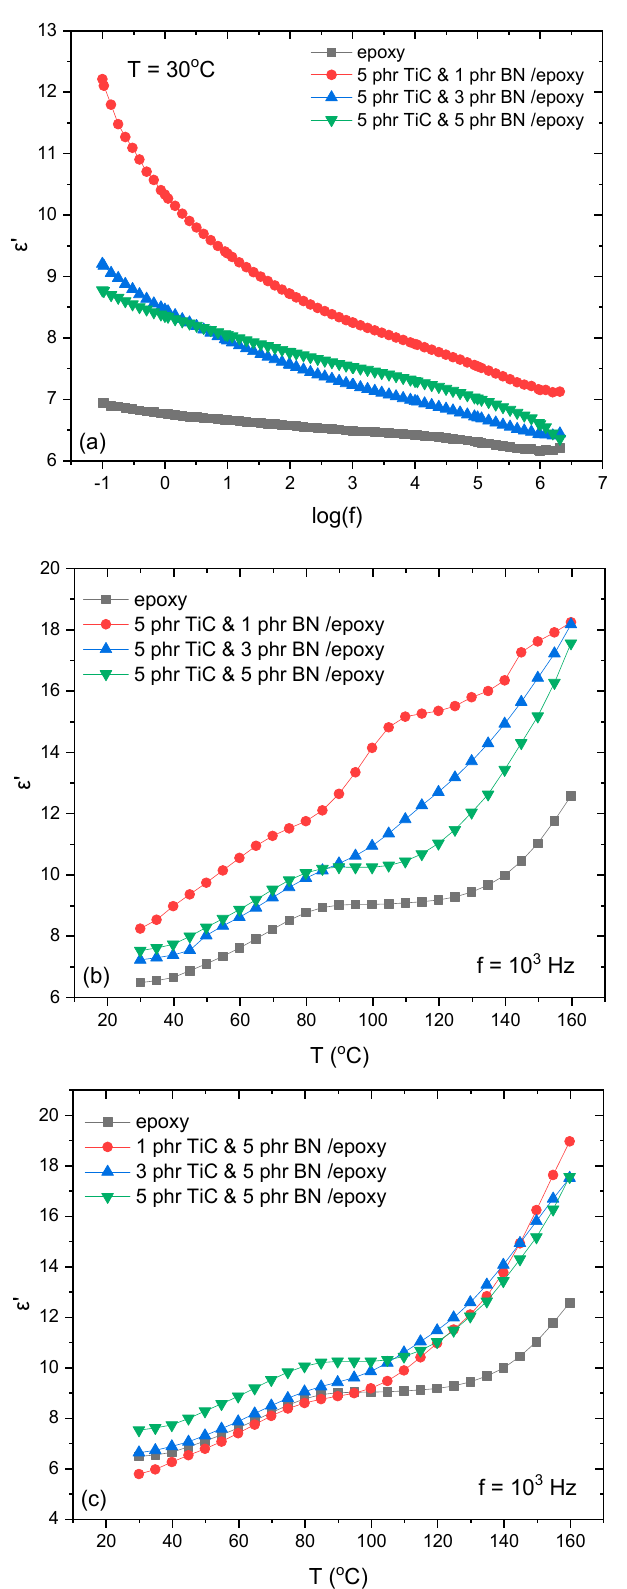
Figure 7. Real part of dielectric permittivity as a function: ( a ) of frequency, at 30 °C, for the systems with 5 phr TiC, varying the BN content, ( b ) of temperature, at 1 kHz, for the same systems as in ( a ), and ( c ) of temperature, at 1 kHz, for the systems with 5 phr BN varying the TiC content.